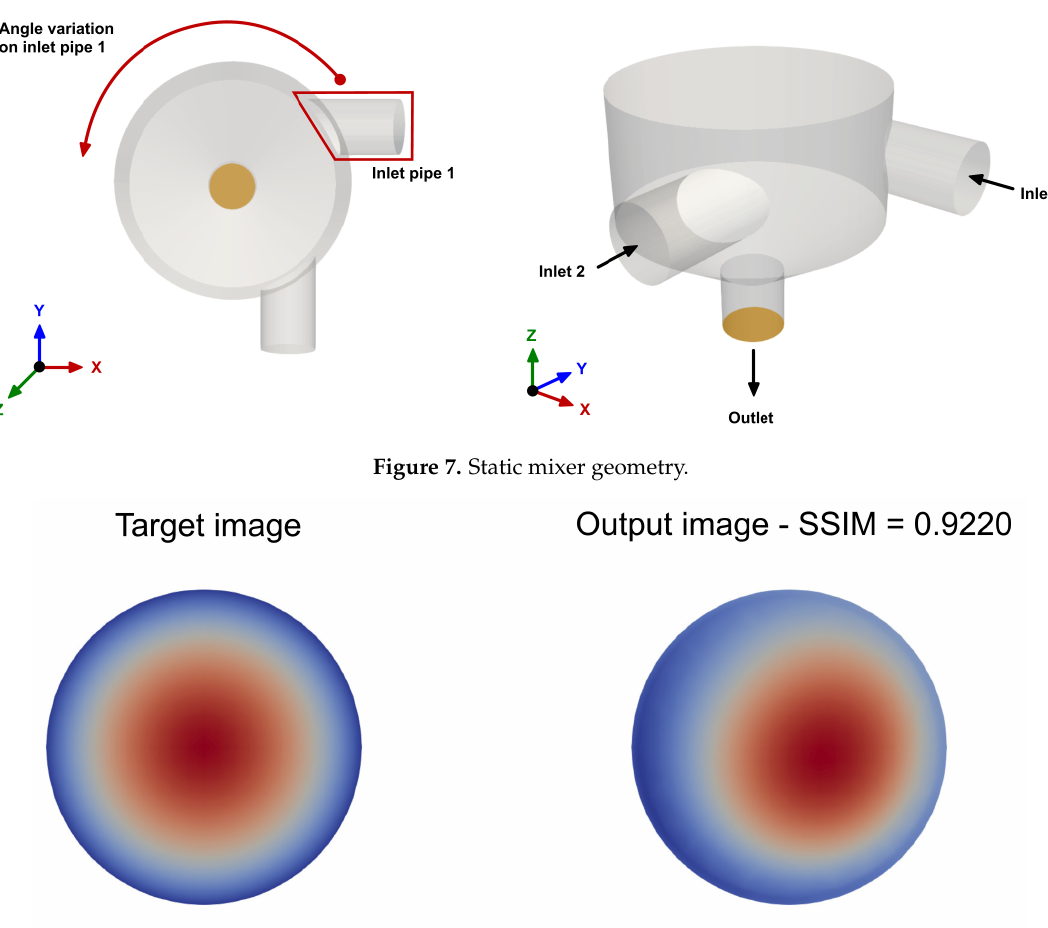
Figure 8. Velocity distribution normal to the outlet surface. Left image: reference velocity distribution or target image. Right image: image of the velocity distribution for a non-optimal case. To determine if the images are similar, we used the SSIM index method. The closer the SSIM index of the output image is to one, the more similar the images